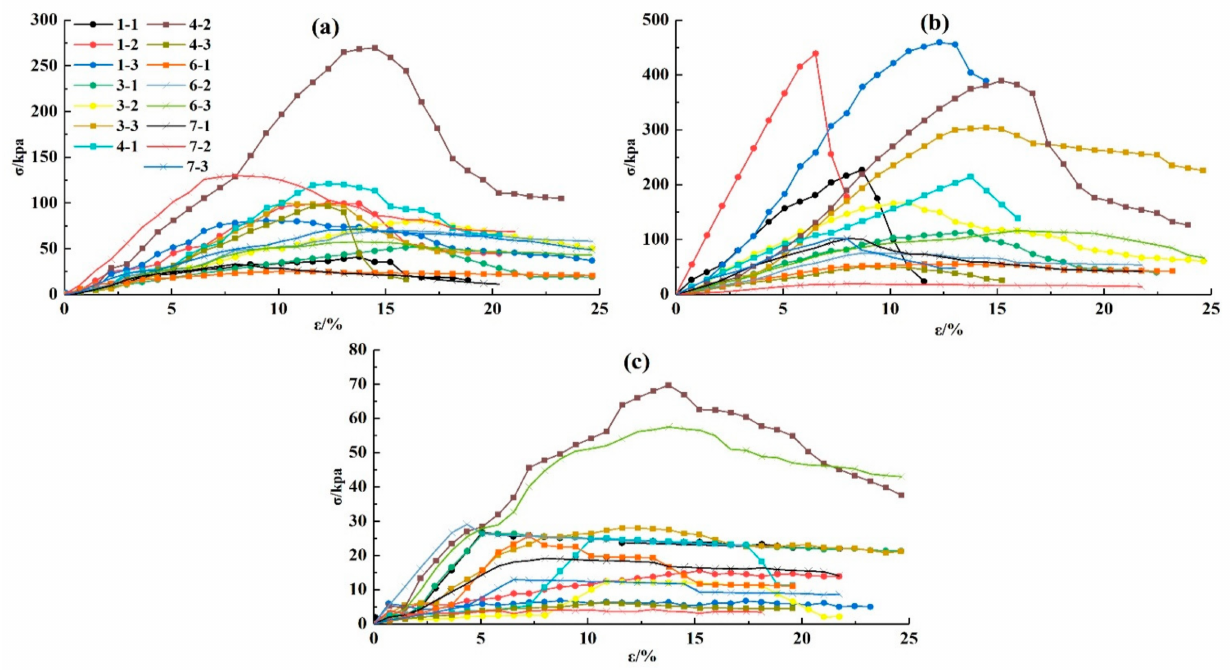
Figure 3. Stress-strain curves of all samples obtained from the unconfined compressive strength tests: ( a ) undisturbed samples, ( b ) remolded samples, and ( c ) saturated